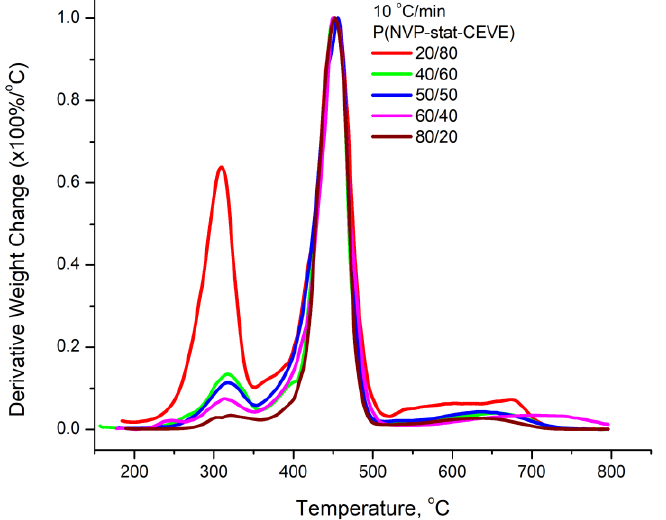
Figure 7. Derivative weight loss with temperature under 10 °C/min heating rate for all statistical copolymers.